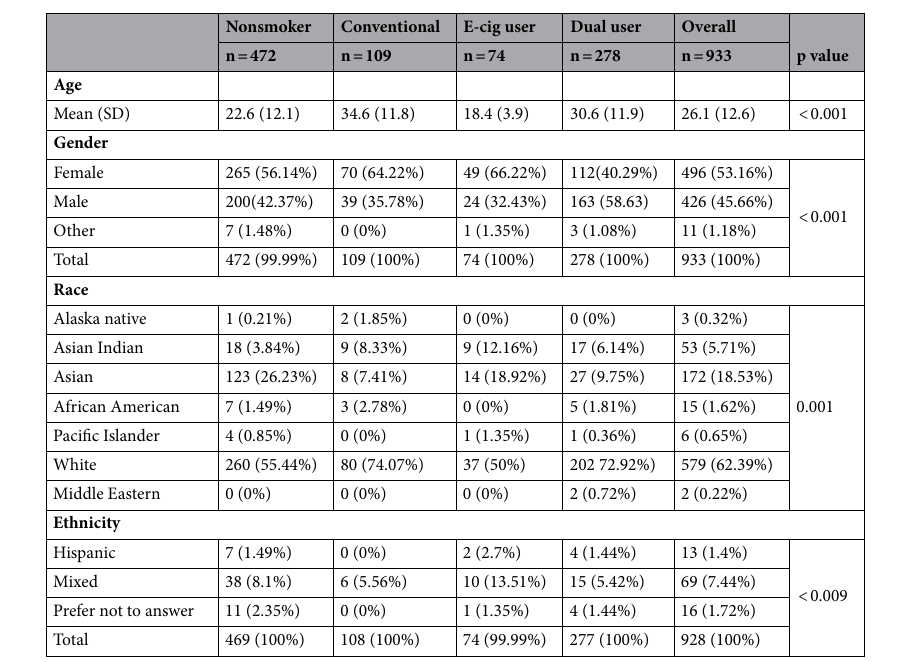
Table 1. Demographics of Survey Responders. *Comparisons among the 4 groups are all significant with p < 0.001. ANOVA test was used for age; and Fisher exact test was used for gender and